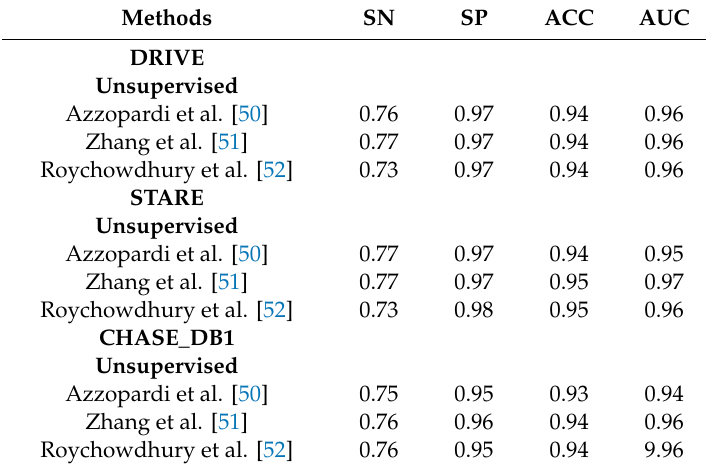
Table 4. Performance comparison with unsupervised methods for retinal vessel